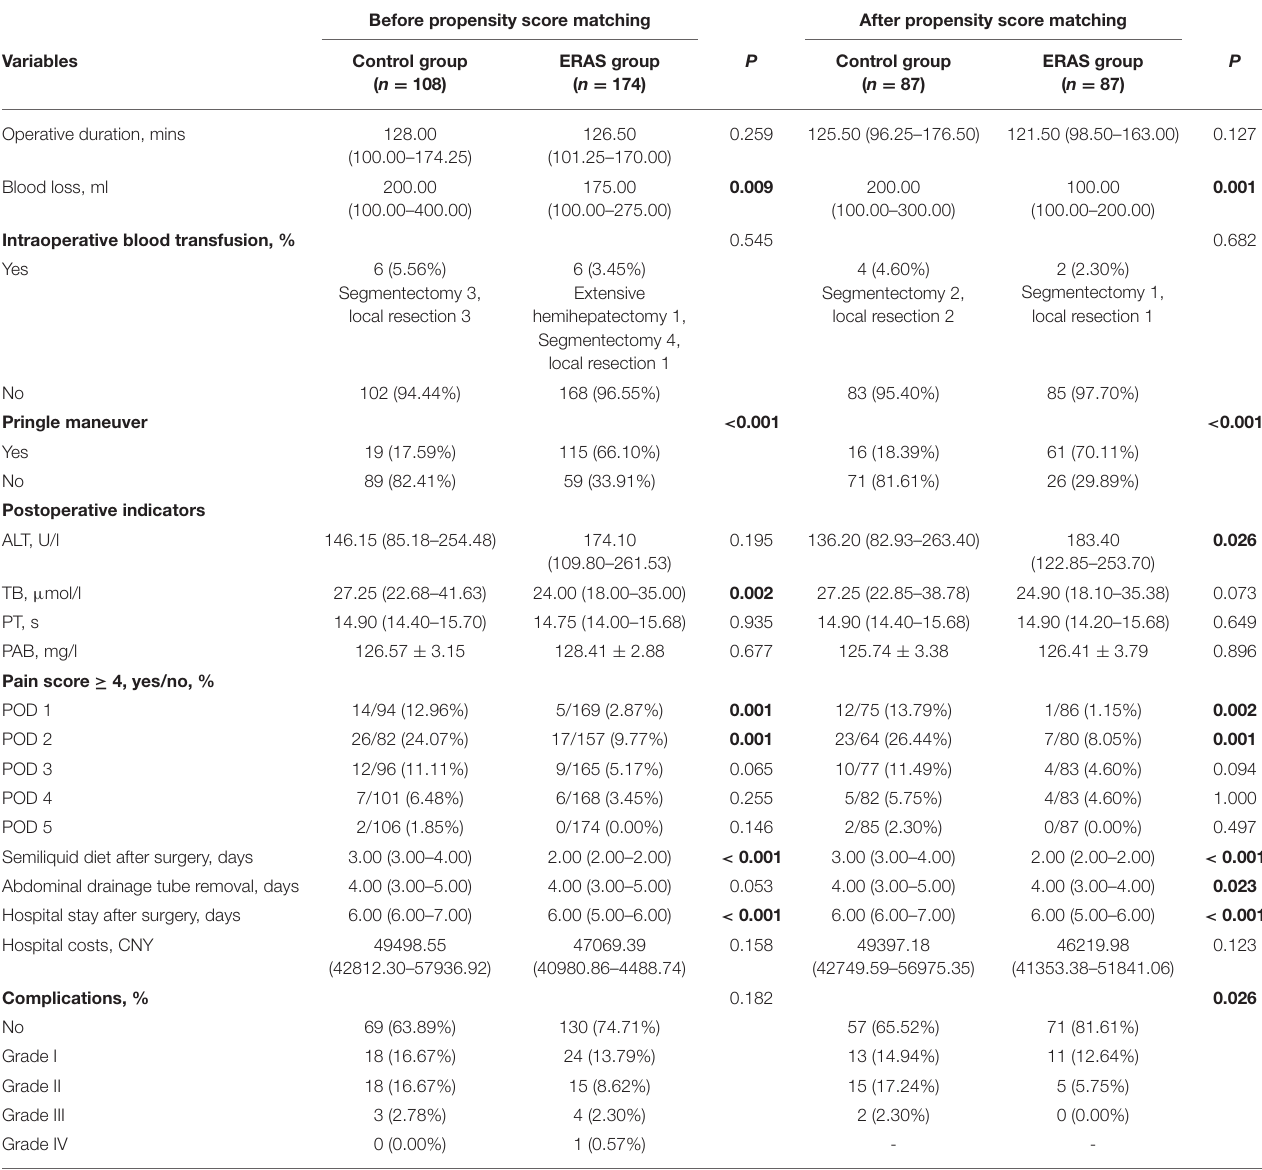
TABLE 3 | The operative results and postoperative